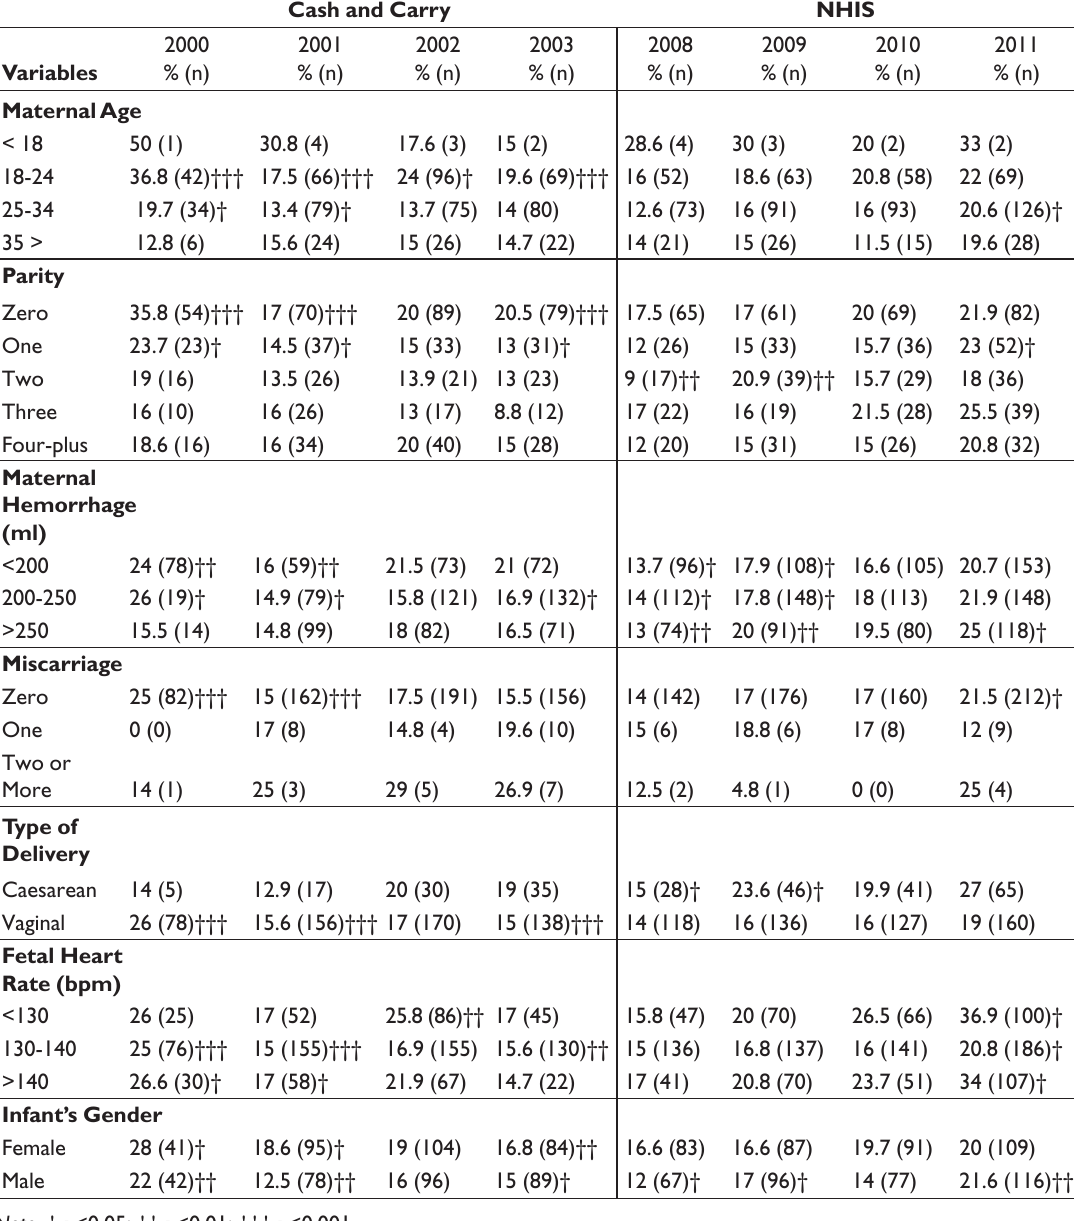
among young mothers (aged 18-24) compared to mothers aged 25 and older. The prevalence of LBW Table 2. A higher prevalence of LBW was observed among younger mothers ranged from 17.5 percent Table 2. Prevalence of LBW in live birth infants during the Cash and Carry and NHIS systems of care, and by selected maternal and other variables in Northern Ghana Cash and Carry